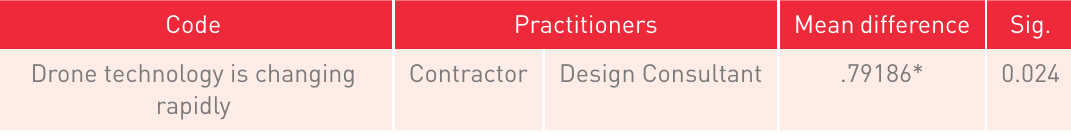
Table 14. Correlations among dimensions of drone readiness Code Understanding & interest Interest & utilisation Understanding & Correlation Significance Correlation Significance Correlation